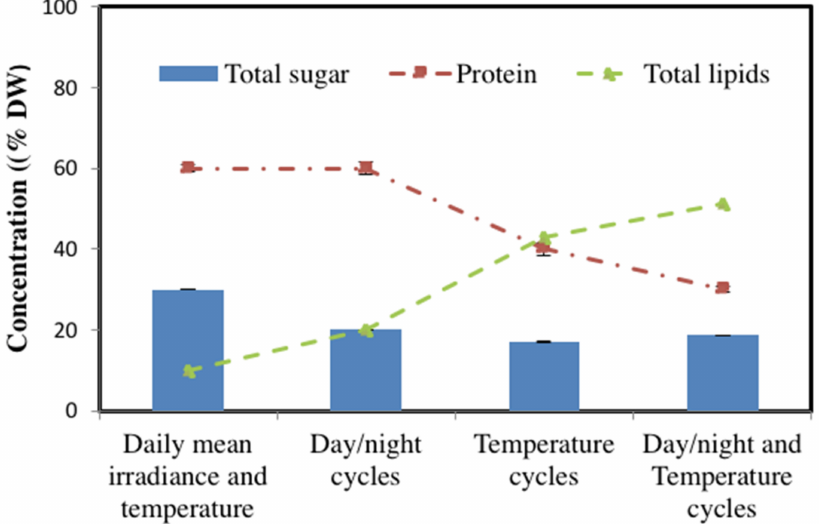
Figure 8. Total sugar, protein and total lipids contents of N . sp QU130 after the implementation of fluctuation stress of three different cultivation regimes: Cultivation under constant light and temperature, day/night cycles, temperature fluctuation and combined light and temperature